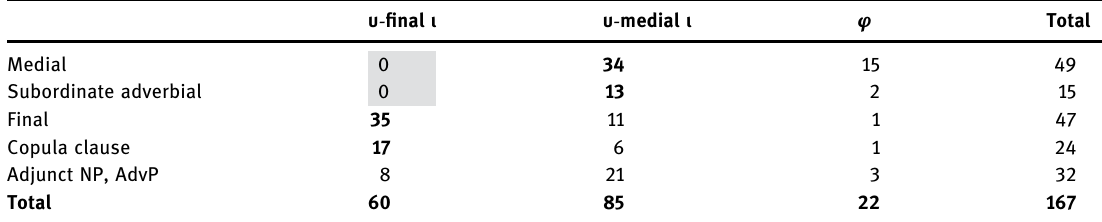
Bold fi gures highlight those prosodic mappings that we consider to be default mappings. Shaded cells highlight prosodic mappings that never occur in our data.